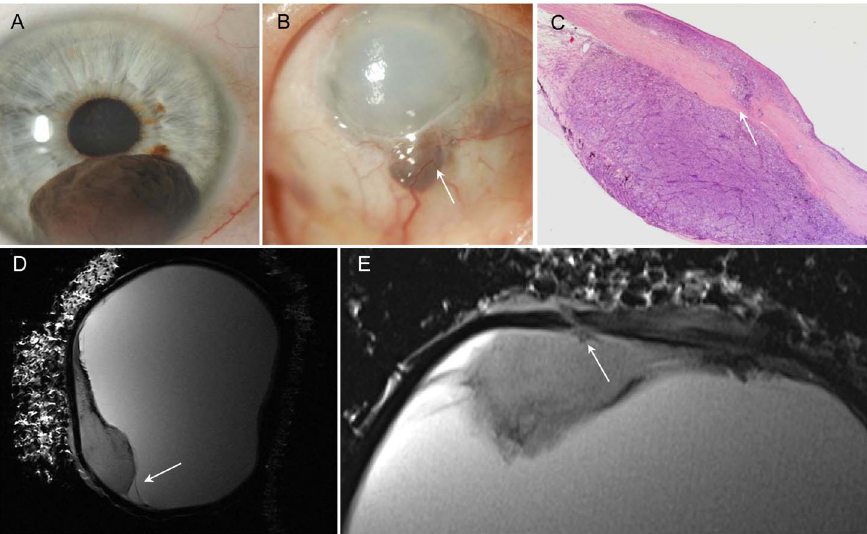
Figure 2. Malignant melanoma of iris and ciliary body with scleral perforation two years after iridocyclectomy. A – Photograph: malignant melanoma of iris at 6 o’clock before surgery (iridocyclectomy). B – Photograph: recurred tumor with scleral perforation at 6 o’clock, vascularization and corneal edema (arrow). C – H&E stain, 2 6 magnification: tumor extends through the sclera (arrow). Conjunctiva demonstrates mushroom-like detachment. D – Sagittal T2w image: tumor with hypointens rim (paramagnetic effect of melanin) and retinal detachment (arrow). E – Axial T2w image: delineation of the melanoma from the bulbar wall and good visualization of the perforation (arrow).